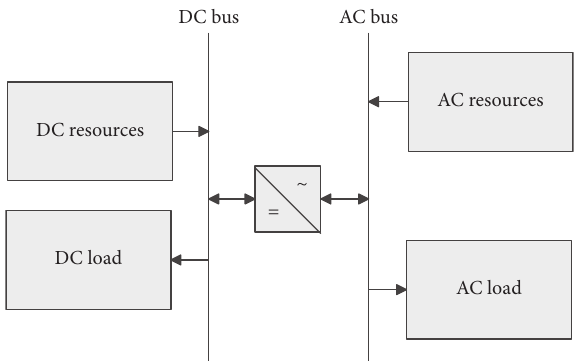
Figure 5: Hybrid AC/DC bus